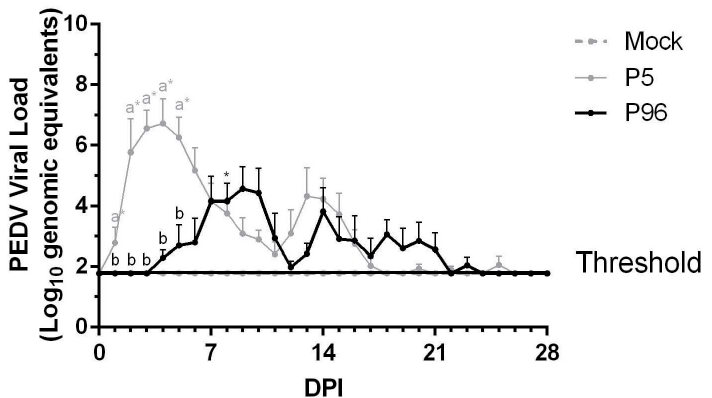
Figure 3. Fecal shedding of PEDV in 5-week-old pigs after porcine epidemic diarrhea virus strain Pintung 52 (PEDVPT)-P5 or PEDVPT-P96 inoculation. Changes in the mean values of genomic equivalents (GE)/mL are shown as log 10 values ± SEM. The threshold indicates the limitation of detection for the SYBR Green-based real-time PCR (RT-PCR). The black, gray, and dashed lines illustrate the results obtained for the PEDVPT-P96-inoculated group, PEDVPT-P5-inoculated group, and mock-infected group, respectively. *: significant difference with the mock group ( p < 0.05); a, b: significant difference between groups labeled with different alphabets ( p < 0.05).